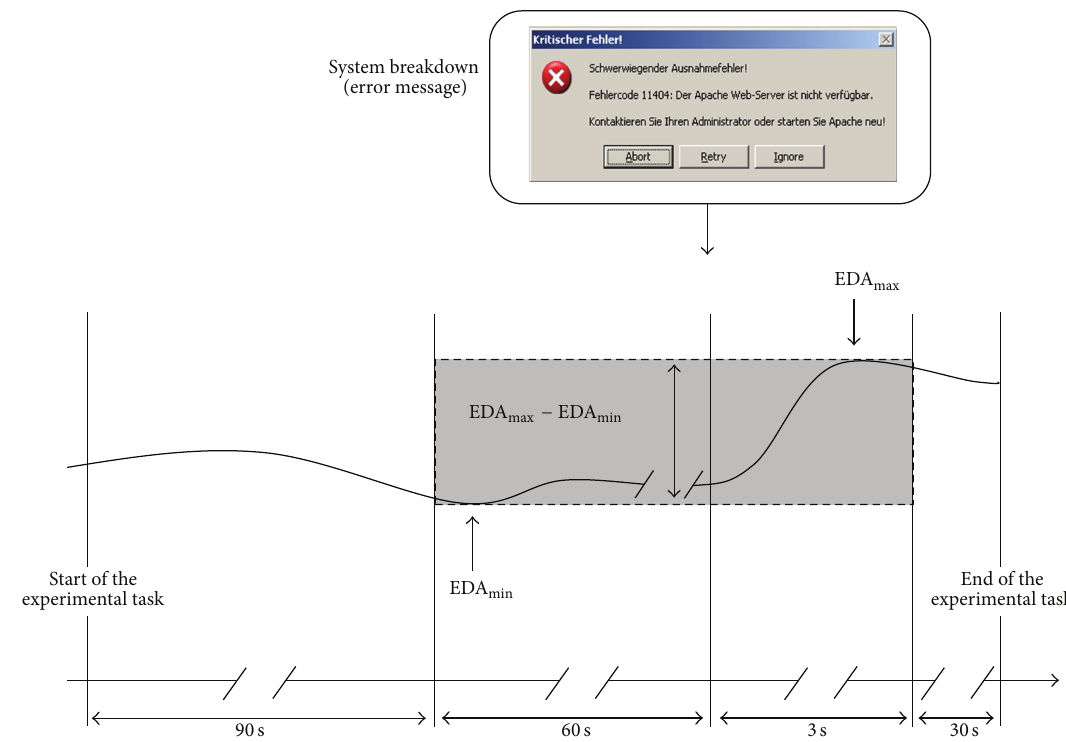
Figure 1: Collection and analysis of EDA data. Notes: The upper part of Figure 1 illustrates the stimulus, the error message which popped up 2.5 minutes after a participant’s first click in the online shop. All stimulus material was presented in German. The error message contains the following text (literal translation): “ Critical Error! Fatal exception error! Error code 11404: The ApacheWeb server is not available. Contact your administrator or restart Apache! ” It was not possible for subjects to click away the error message, because the screen view was frozen. Time intervals that were used for data analyses are illustrated in gray background color, namely, 60 seconds before stimulus onset (prestressor phase) and 3 seconds after stimulus onset (poststressor phase). Changes in electrodermal activity (EDA) in response to discrete events can be expected within a time interval of 3 seconds